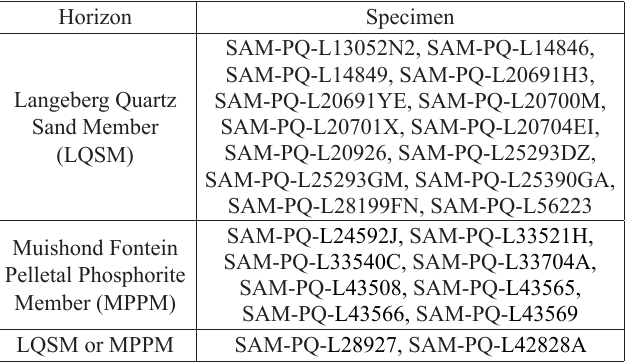
Table 8. Horizon of specimens of Athene inexpectata sp. nov. from the early Pliocene, Upper Varswater Formation at “E” Quarry, Langebaan- weg, South